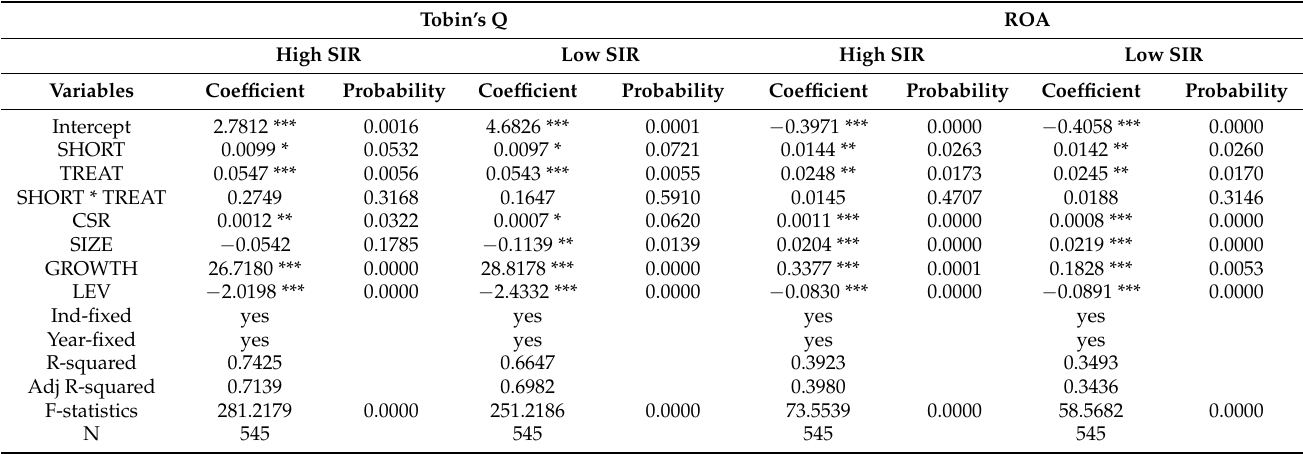
Table 8. Moderating effect of real short-selling threats.